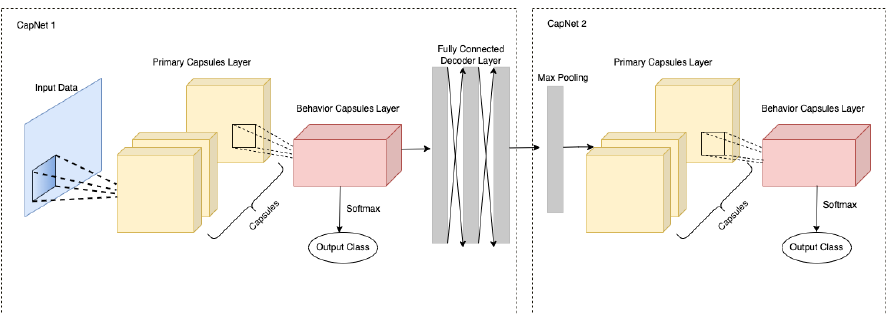
Figure 2. Architecture of the Cascaded Capsules